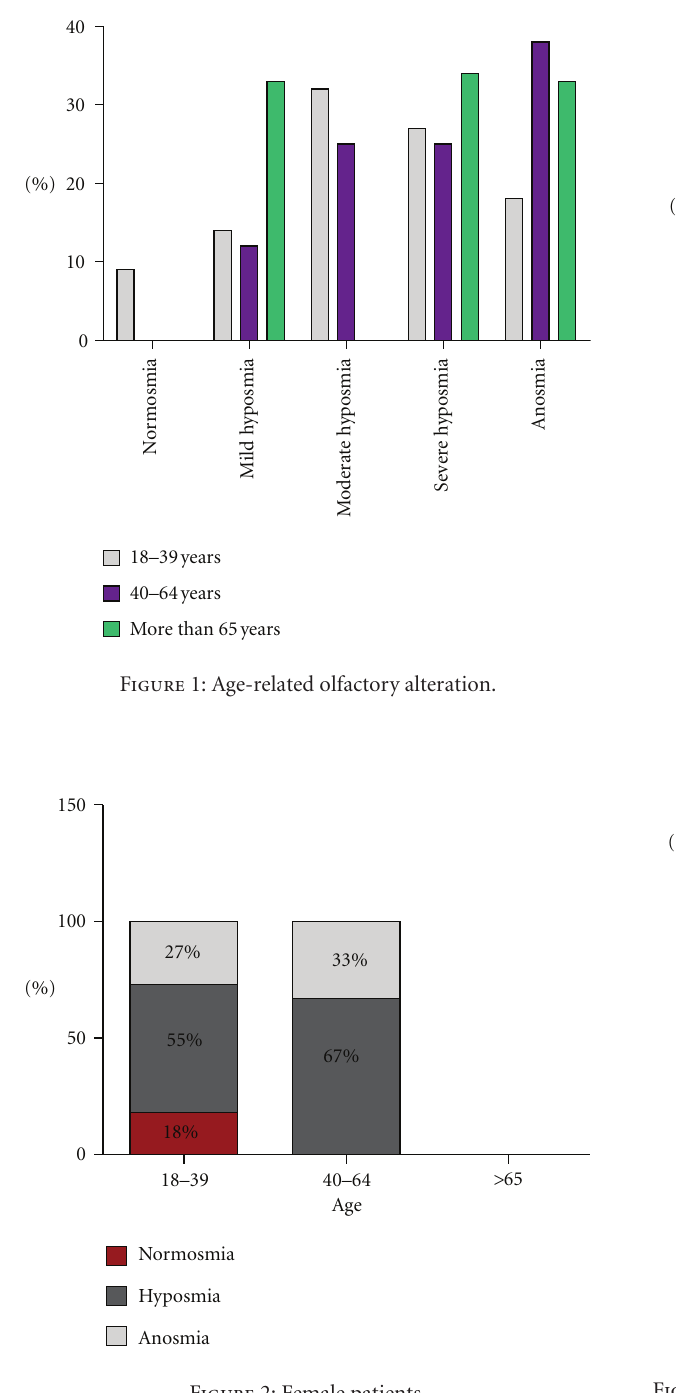
Figure 2: Female patients.